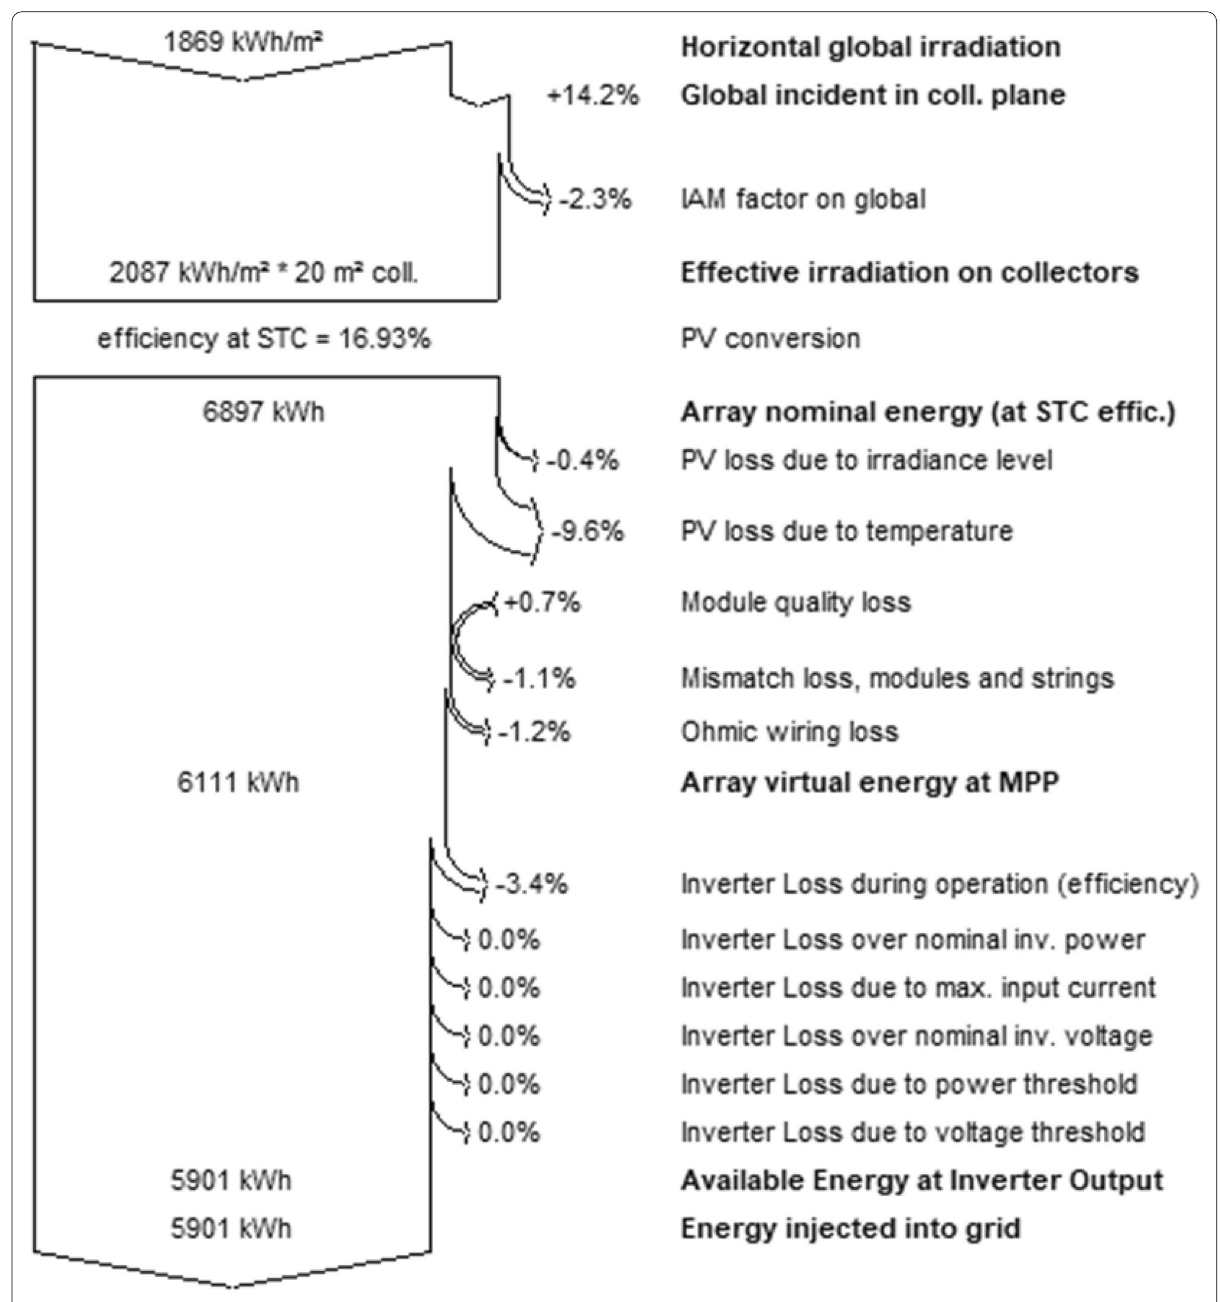
Fig. 11 The arrow loss diagram for monocrystalline solar-grid 3-kWp PV